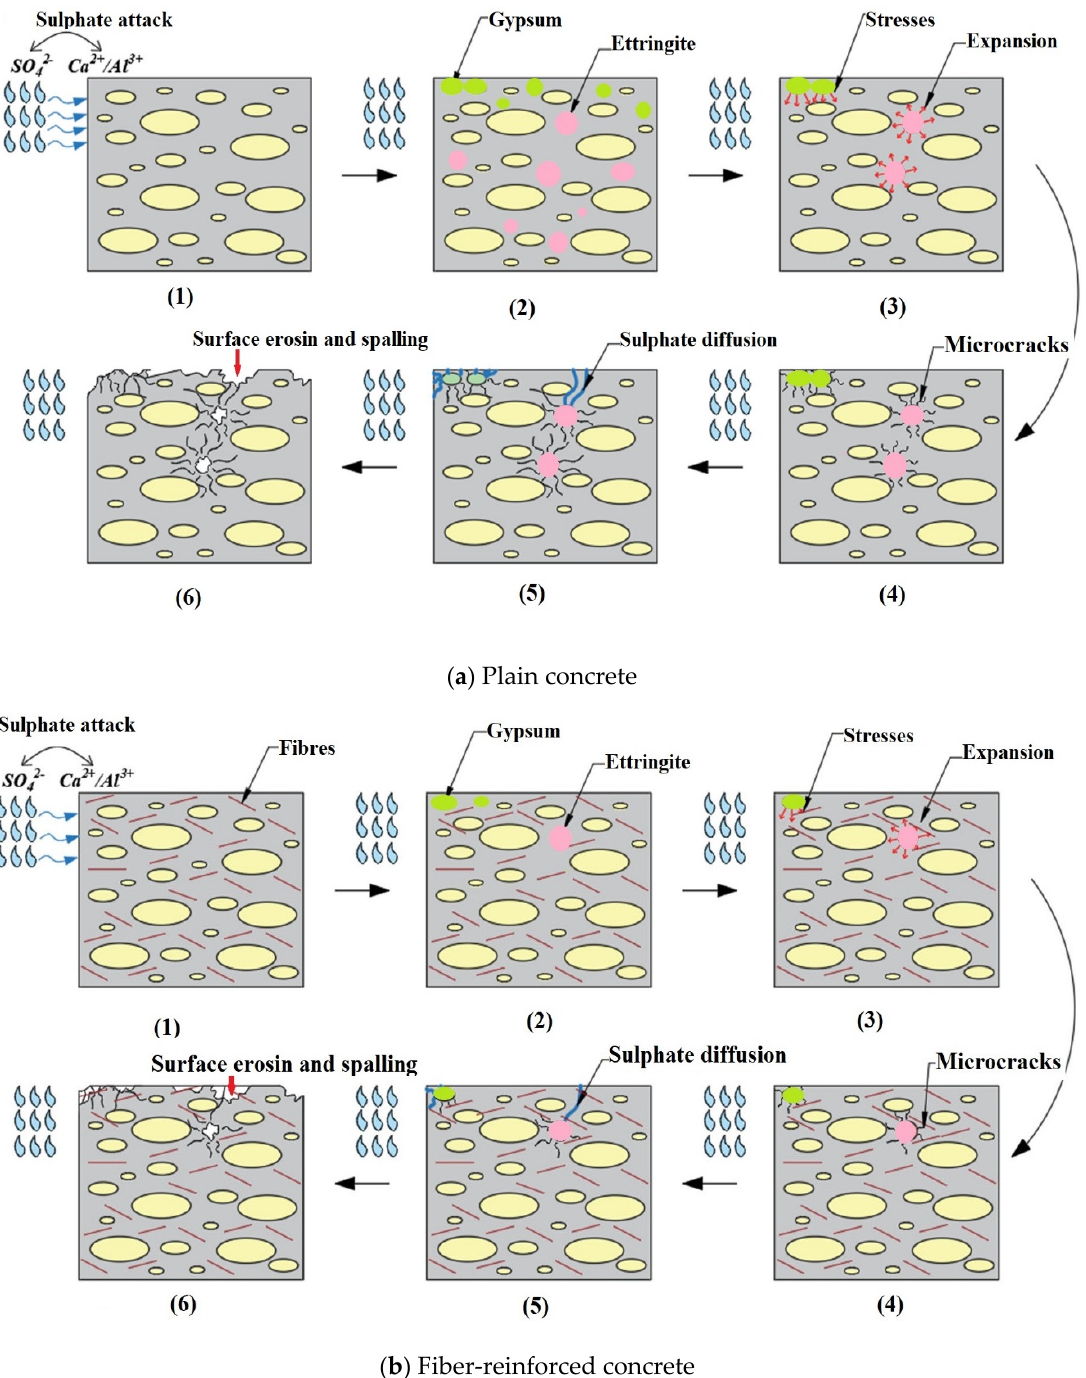
Figure 6. The effects of the WPFT fibers on the mass gain of concrete samples exposed to a MgSO 4 solution.